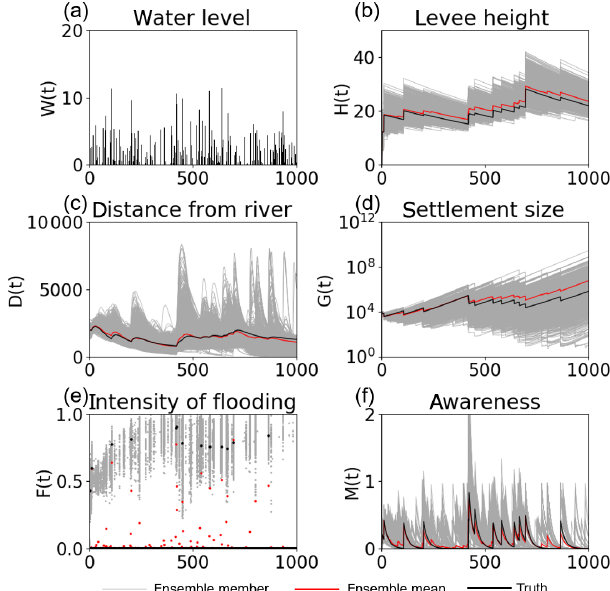
Figure 1. Time series of (a) the high water level W(t) , (b) the flood protection level (or levee height) H(t) , (c) the distance of the center of the mass of the human settlement from the river D(t) , (d) the size of the human settlement G(t) , (e) the intensity of flooding events F(t) , and (f) the social awareness of the flood risk M(t) simulated by 5000 ensembles, with uncertain high water levels and no data assimilation, in experiment 1 (see Sect. 3.1.1). The time step is an- nual. Gray, red, and black lines are the ensemble members, their mean, and the synthetic truth,